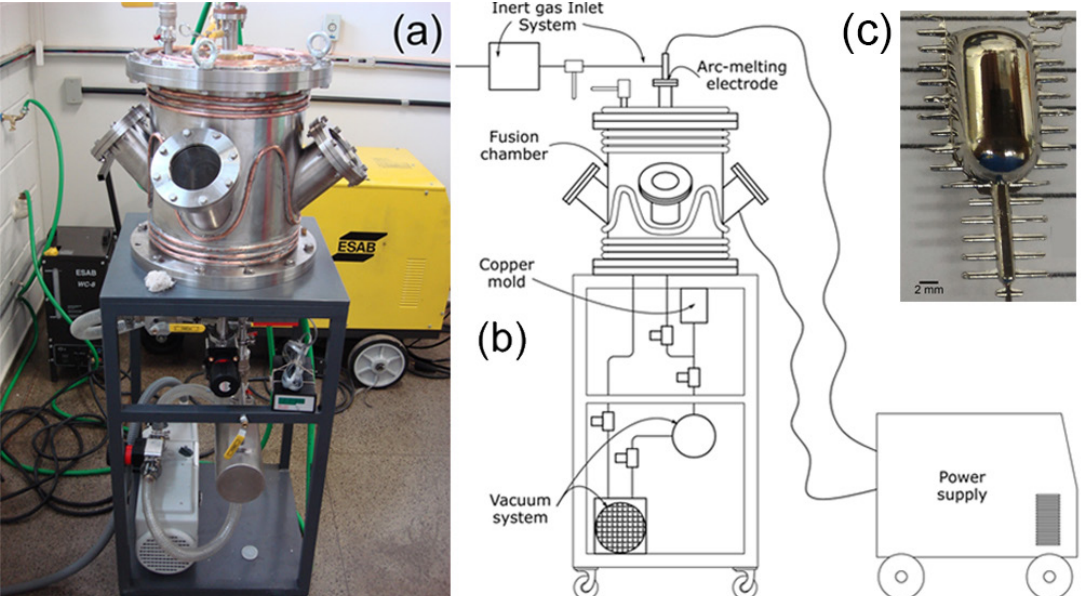
Figure 1: Arc-melting furnace (a) picture of the equipment, (b) drawing, and (c) example of one of the produced samples.